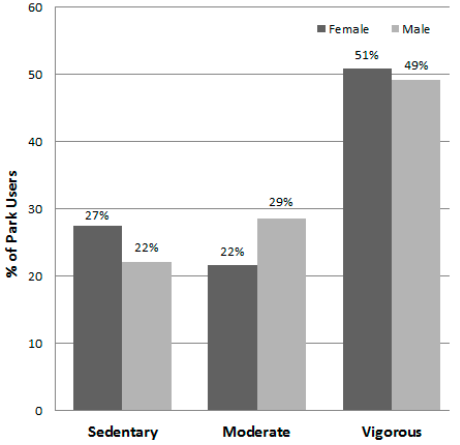
Figure 2. Percent of park users by physical activity levels and gender ( n = 28,585).